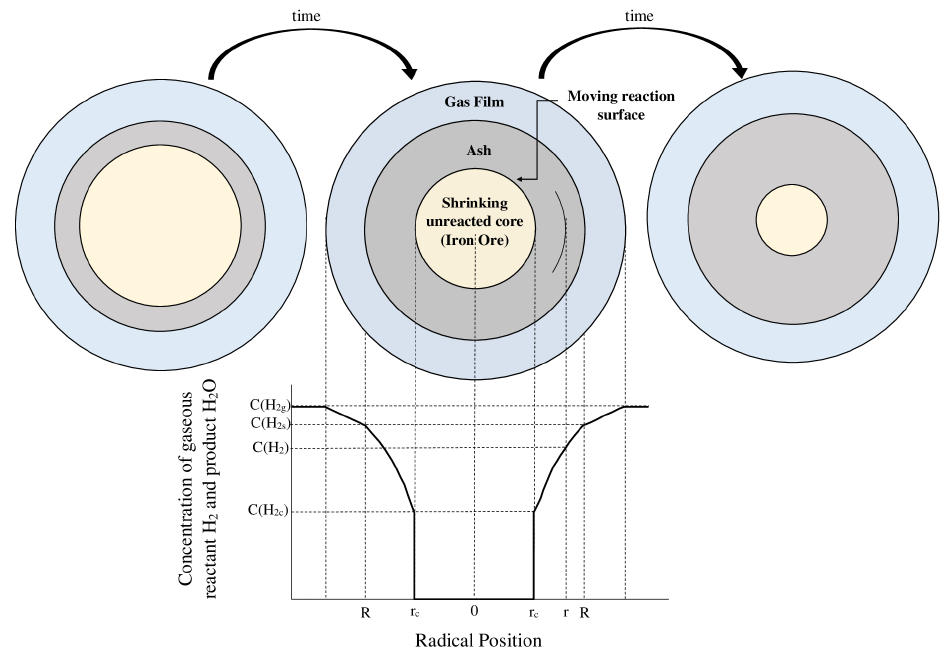
Figure 1. Schematic shrinking core model modified after [21] “modified”.